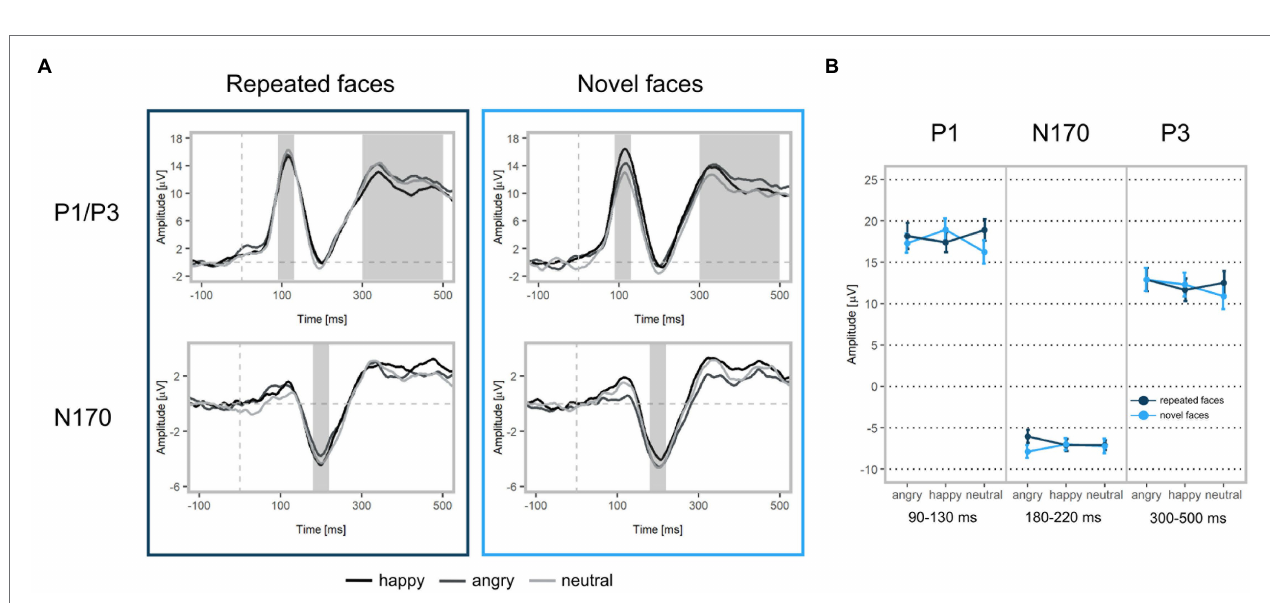
FIGURE 4 | ERP waveforms and mean amplitudes at Face 2. (A) Upper left: Grand-averaged P1 and P3 waveforms for repeated happy (black), angry (dark grey), and neutral (light grey) facial expressions (ROI: PO3, PO4, PO7, PO8, O1, O2, Oz). Upper right: Grand-averaged P1 and P3 waveforms for novel facial expressions. Bottom left: Grand-averaged N170 waveforms for repeated happy, angry, and neutral facial expressions (ROI: P7, TP7, CP5, P8, TP8, CP6). Bottom right: Grand- averaged N170 waveforms for novel facial expressions. Shadowed areas indicate the time windows used to identify participants’ individual peaks and mean amplitudes. (B) Mean P1, N170, and P3 amplitudes and standard deviations separately for each